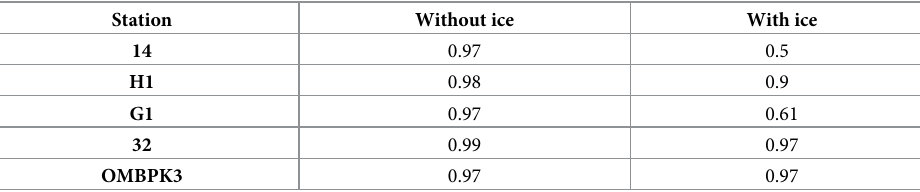
Table 1. Dia/Dino index average between 10 March-05